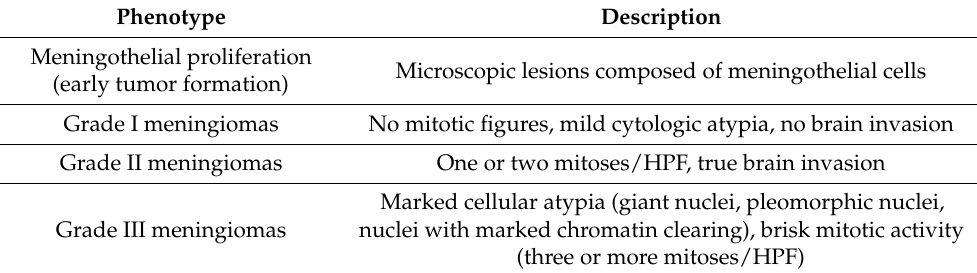
Table 4. GEMM classification for meningiomas